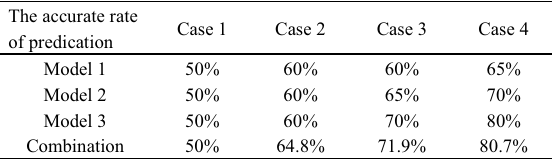
Table 2. An exemplification of the Lemma 1 and the Corollary